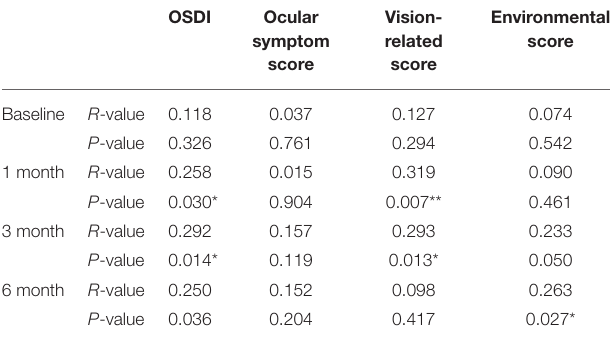
TABLE 2 | Correlation between the degree of meibomian gland loss and OSDI score at each time point before and after surgery. OSDI Ocular symptom score